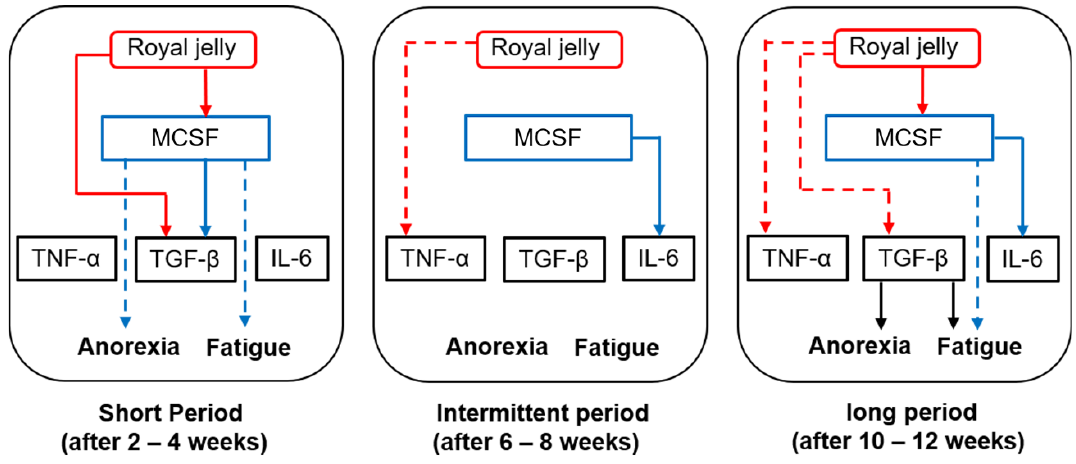
Figure 2. Interactions between royal jelly (RJ), macrophage colony stimulating factor (M-CSF), and inflammatory mediators after short-, intermediate-, and long-term treatment with RJ. Red lines—effects of RJ; blue lines—effects of M-CSF; black lines—effects of transforming growth factor (TGF- β). Solid lines and dotted lines refer to an increase and decrease in post-/pretreatment serum levels, respectively.